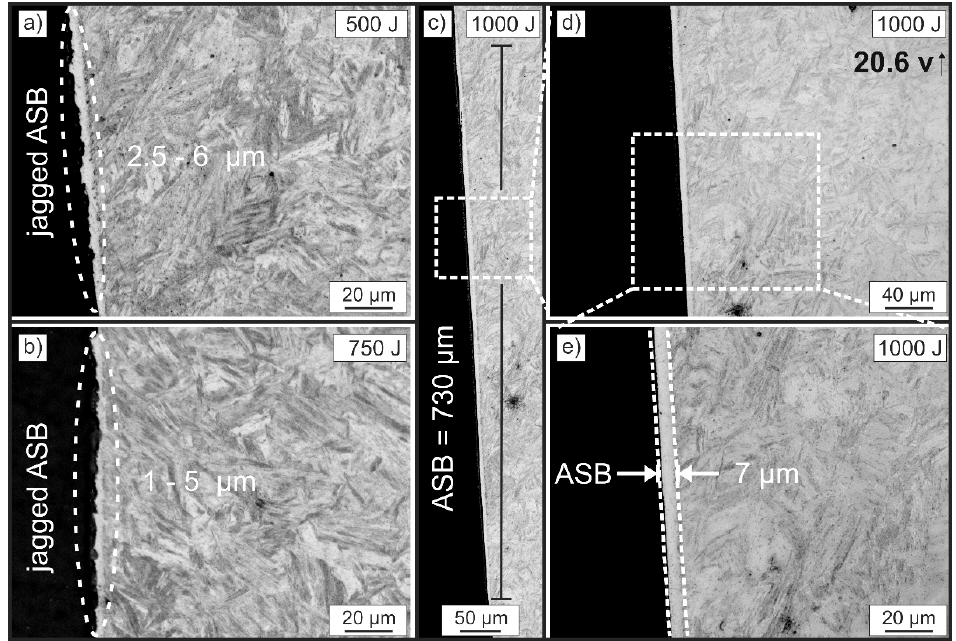
Figure 9. Optical microscopy images with increased resolution of the ASB of the 20.6 v ↑ samples from ( a ) 500 J, ( b ) 750 J and ( c – e ) 1000 J.